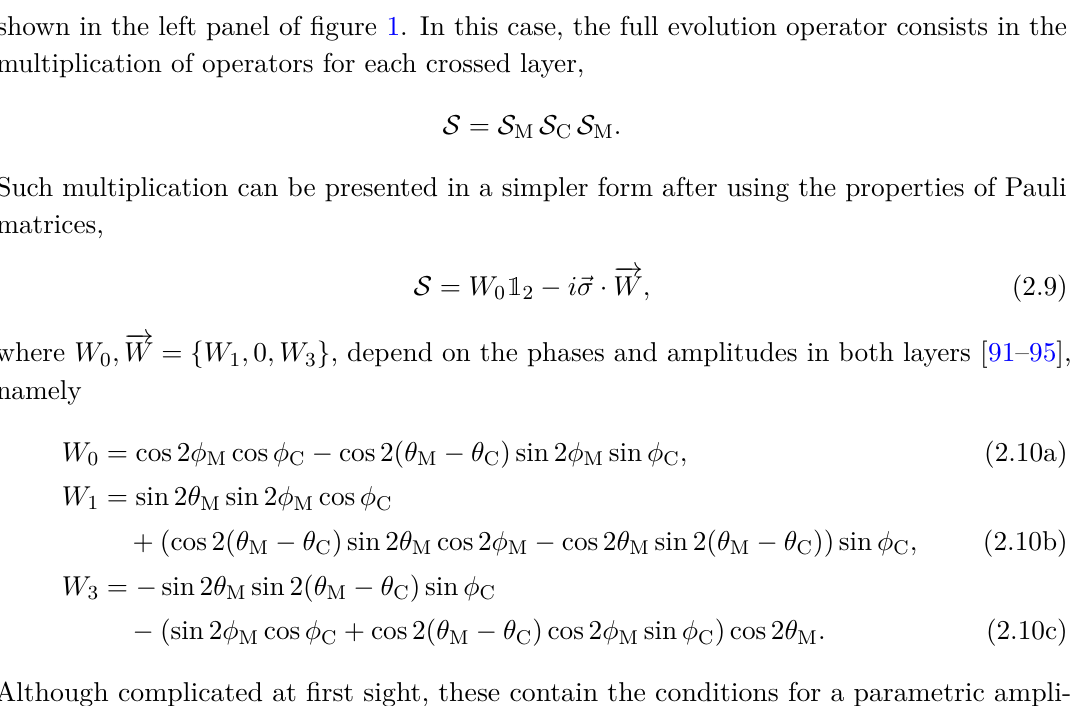
shown in the left panel of figure 1. In this case, the full evolution operator consists in the multiplication of operators for each crossed layer,